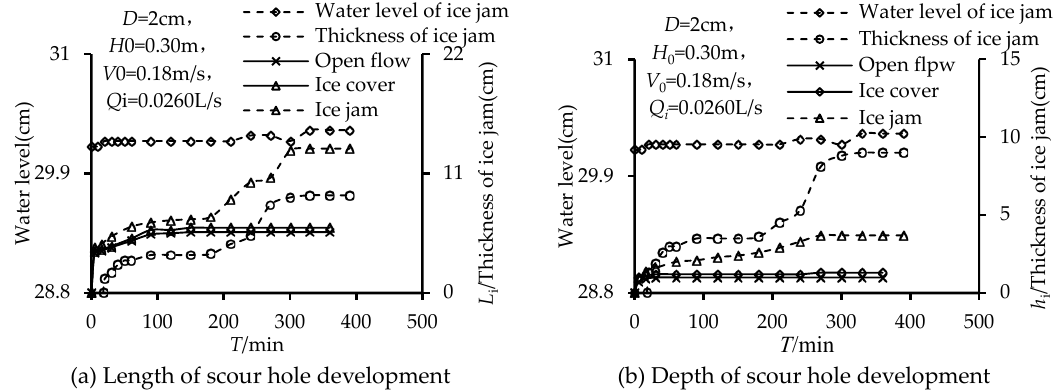
Figure 16. Comparison of the development of a scour hole around a pier under open flow, ice cover and ice jam conditions in Case 2.